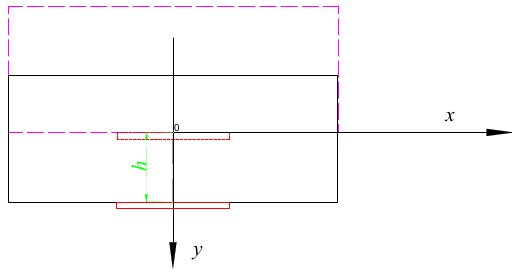
Figure 5. Extension deformation of cable after impact.